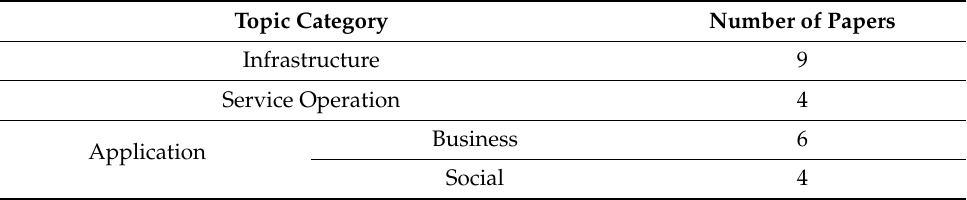
Table 3. Number of papers by topic